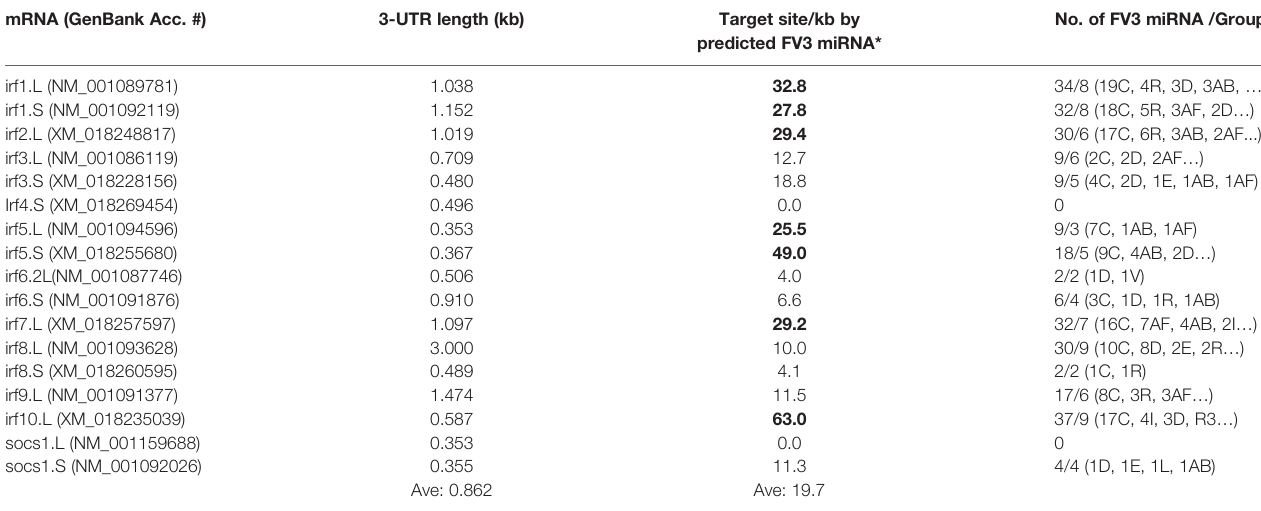
TABLE 2 | Distribution of predicted FV3 miRNA targeting sites in the mRNA 3-UTR regions of interferon regulatory factors (irfs). mRNA (GenBank Acc.